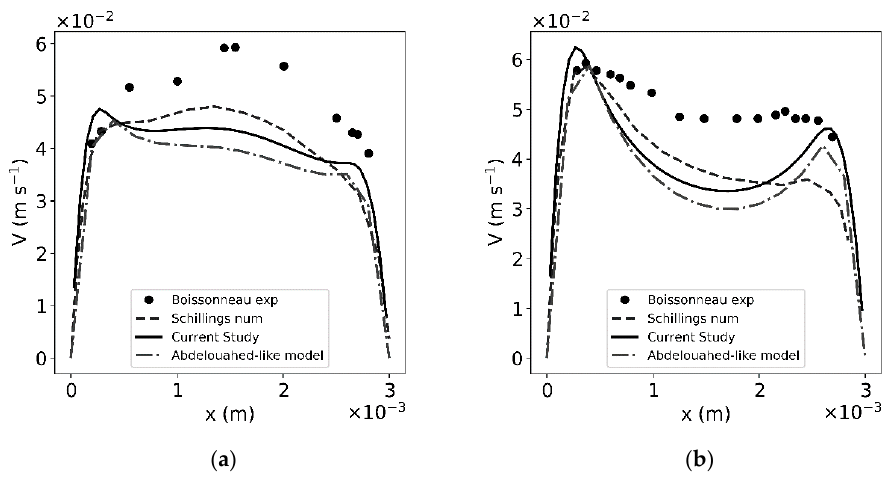
Figure 3. Result of the liquid velocity in different models at j = 500 A m − 2 ( a ) at y = 60 mm and ( b ) at y = 75 mm. The dot are the data from Boissonneau et al. [15], the grey dashed line is the numerical results of the Schilling et al. model [14], the dotted and dashed line is a model using the method of Abdelouahed et al. [26]. Finally, the black solid line the results from the current study with 2D approximation.